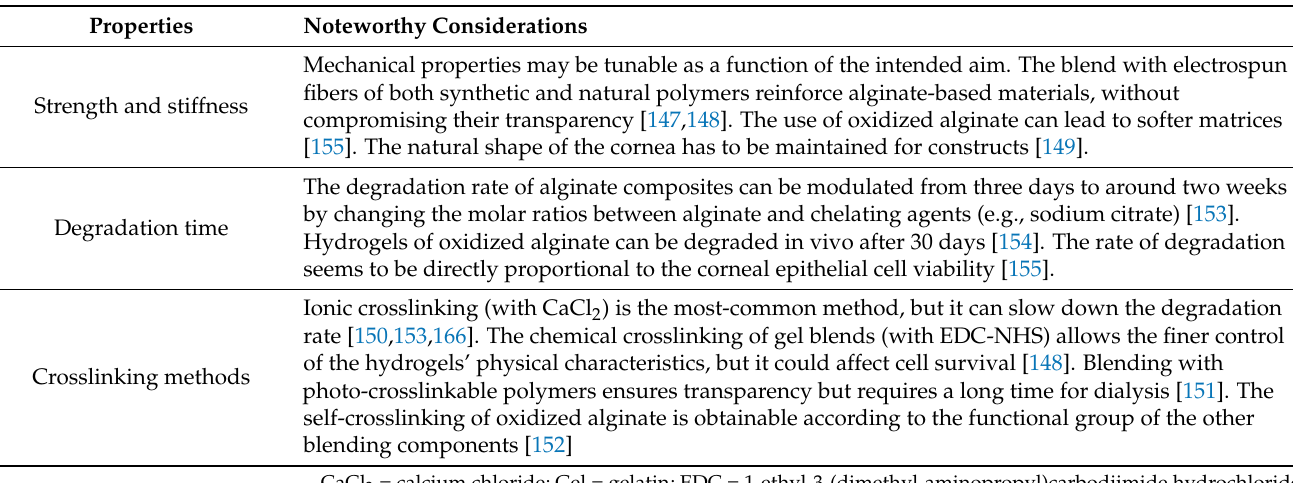
Table 2. Variable properties of alginate-based materials to be considered and highlighted in corneal TERM